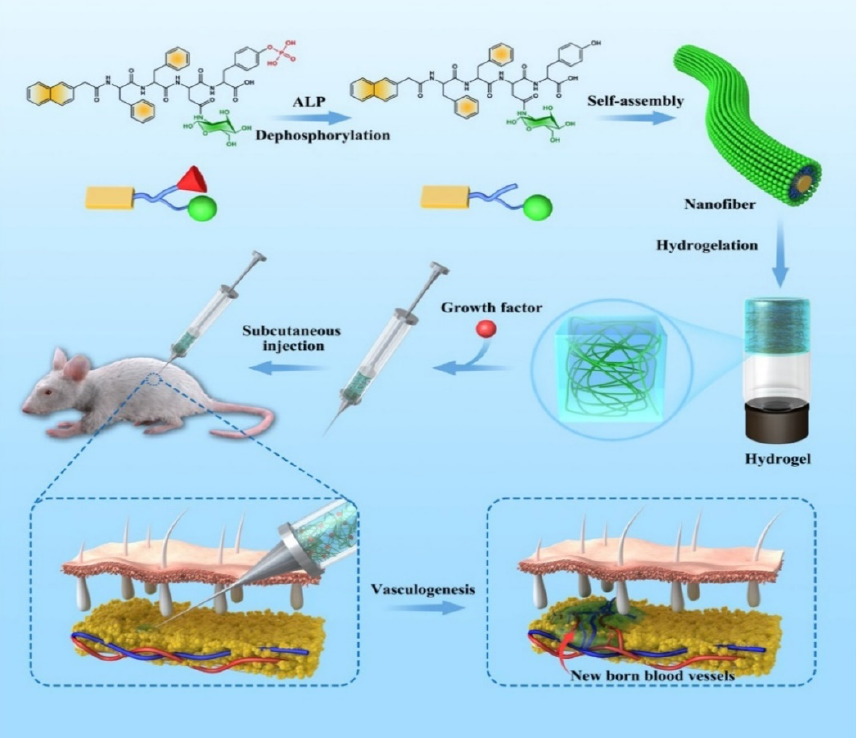
Figure 78. Schematic illustration of the glycopeptide self-assembly and its utilization as a cell growth medium. Reprinted with permission from [152]. Copyright 2020 American Chemical Society.